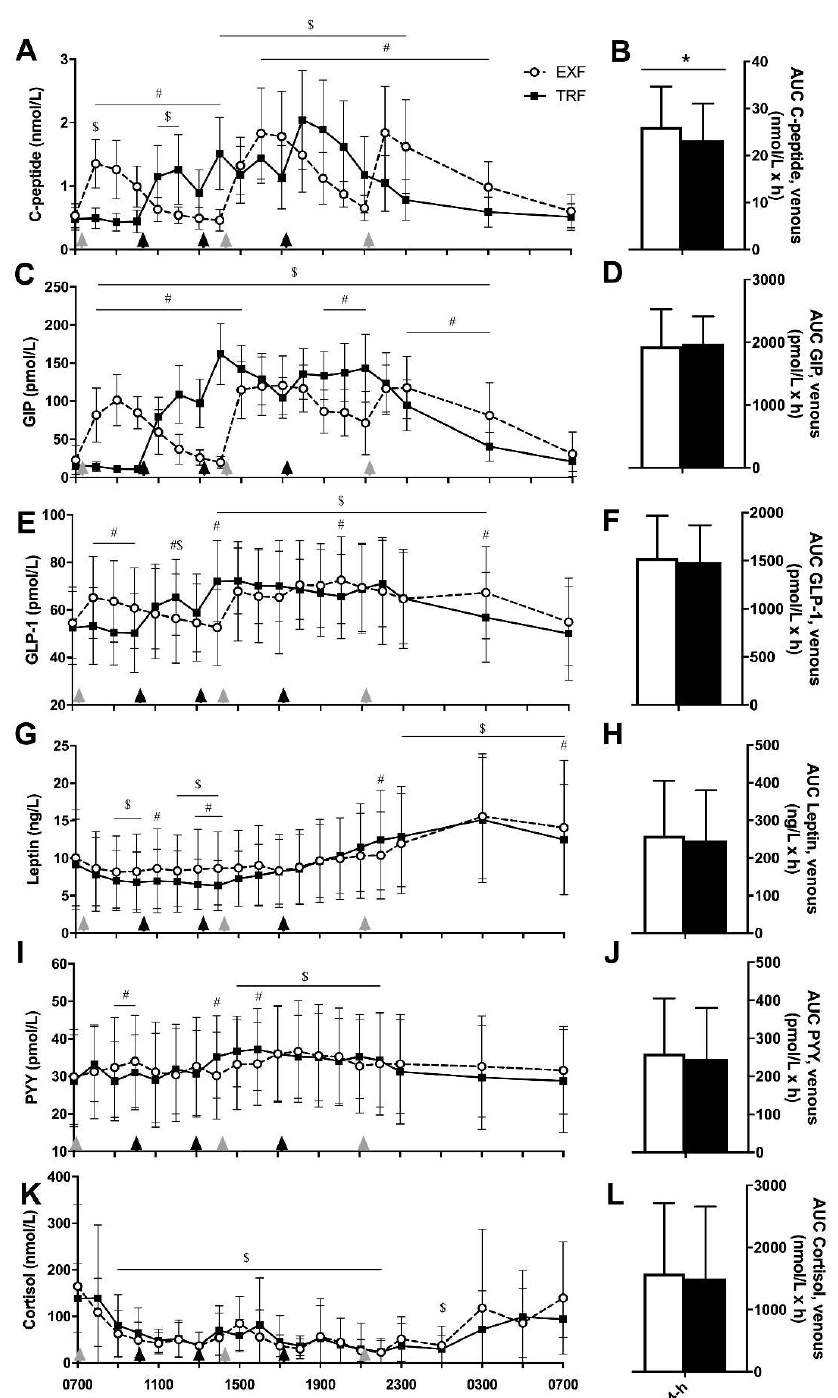
Figure 5. Venous c-peptide ( A , B ), glucose-dependent insulinotropic polypeptide (GIP; C , D ), glucagon-like peptide 1 (GLP-1; E , F ), leptin ( G , H ), peptide tyrosine tyrosine (PYY; I , J ) and cortisol ( K , L ) concentrations over time and AUC total , respectively, from participants with overweight / obesity (n = 10) throughout trial conditions of time-restricted feeding (TRF; black squares and lines) and extended feeding (EXF; white circles and dotted lines). Black triangles represent TRF mealtimes whereas grey triangles represent EXF mealtimes. Data are mean ± SD. p < 0.05 for * main e ff ect of condition; # significantly di ff erent between conditions within time point; $ significantly di ff erent to baseline (0700 h; e ff ect of